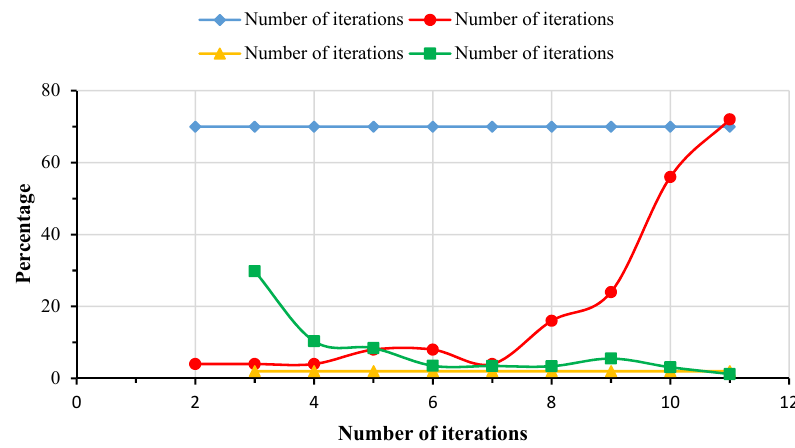
Figure 4. Convergence criteria for optimization of carbon / epoxy lay-up [ β 1S / β 2T ].